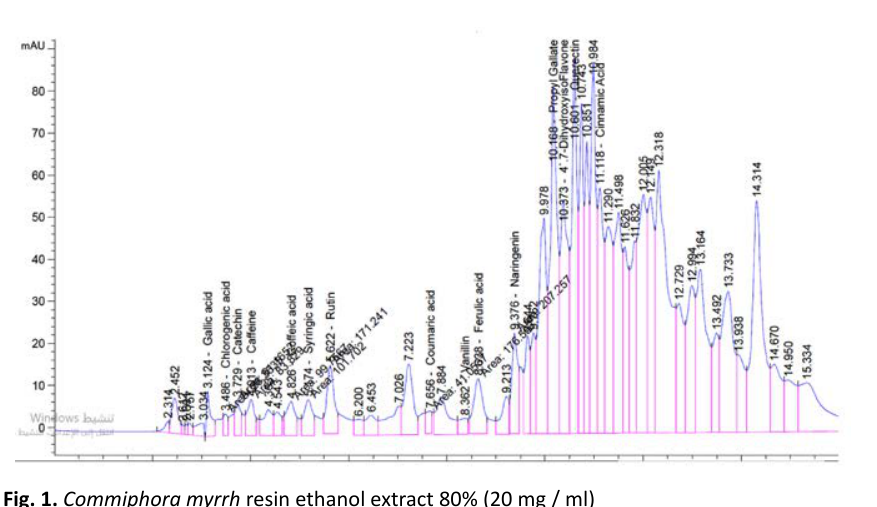
Fig. 1. Commiphora myrrh resin ethanol extract 80% (20 mg / ml)